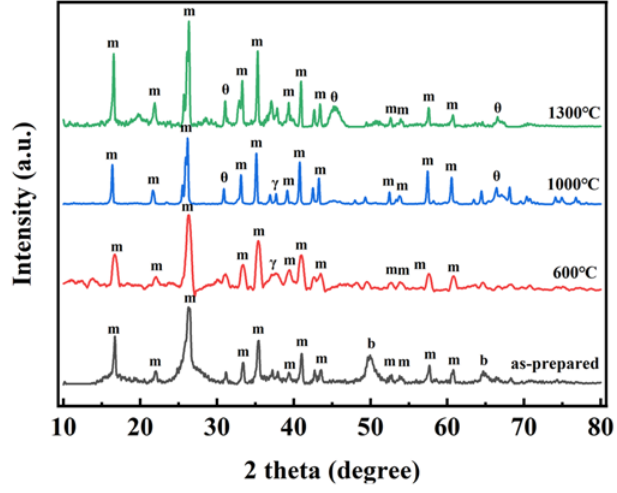
Figure 5. XRD patterns of sample AM4 treated at different temperatures. m: mullite, b: boehmite, γ : γ‐ Al 2 O 3 , θ : θ‐ Al 2 O 3.